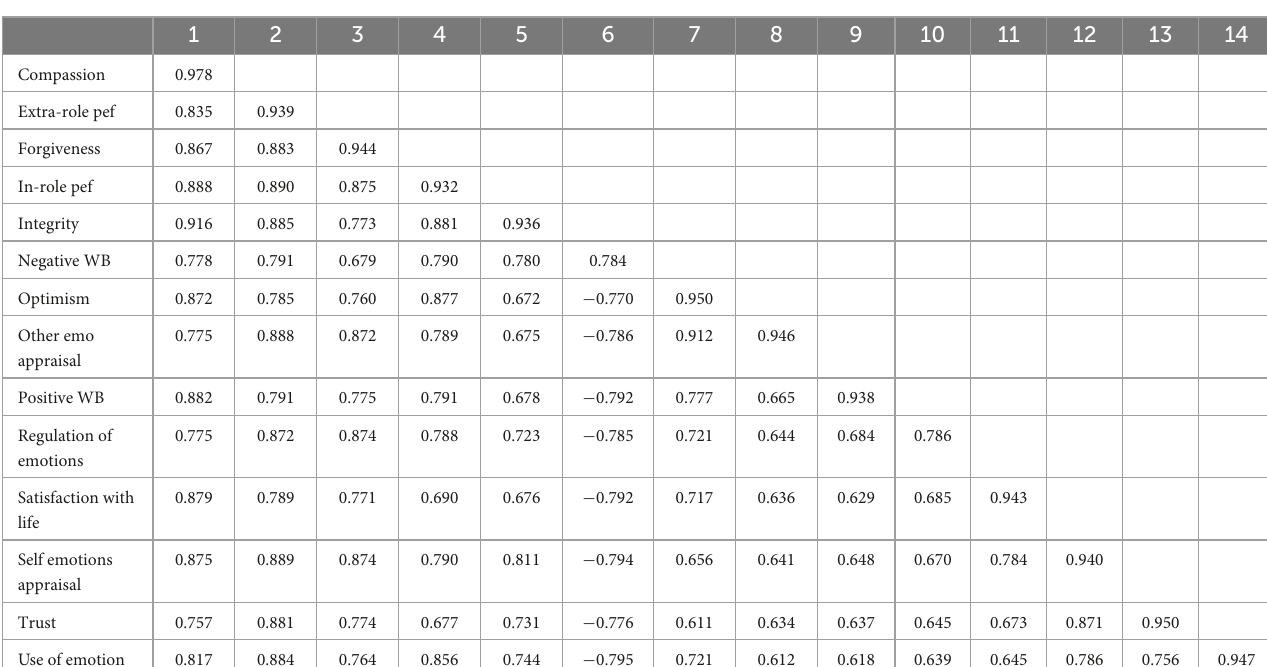
TABLE 3 Fornell-Larcker